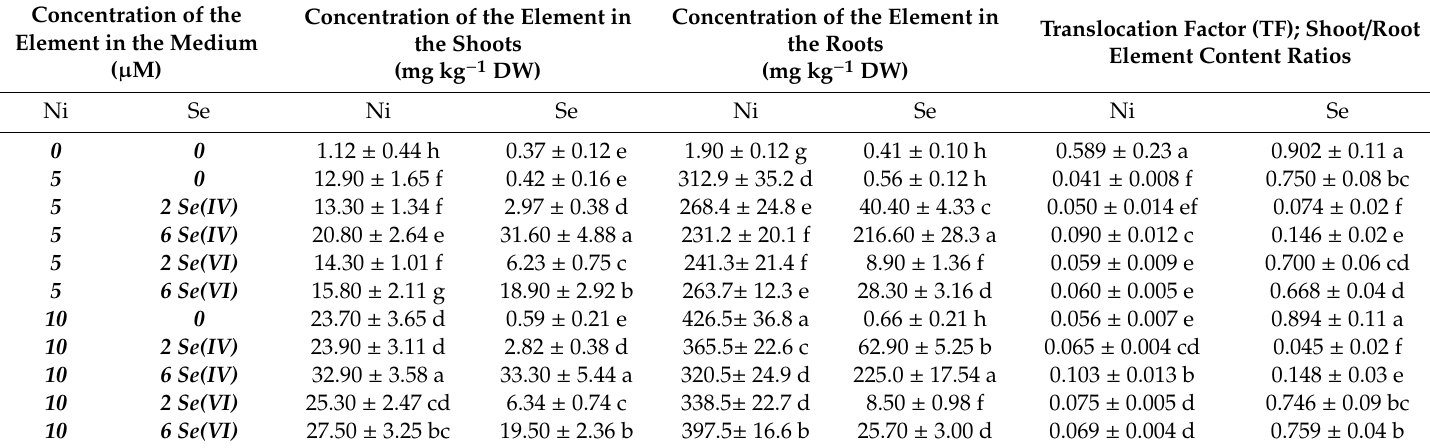
Table 1. E ff ect of Se supplementation on Ni and Se concentrations in the shoots and roots of Ni-exposed lettuce after 14 days of exposure. Concentration of the Concentration of the Element in Concentration of the Element in Translocation Factor (TF); Shoot / Root Element in the Medium the Shoots the Roots Element Content ( µ M) (mg kg − 1 DW) (mg kg − 1 DW)